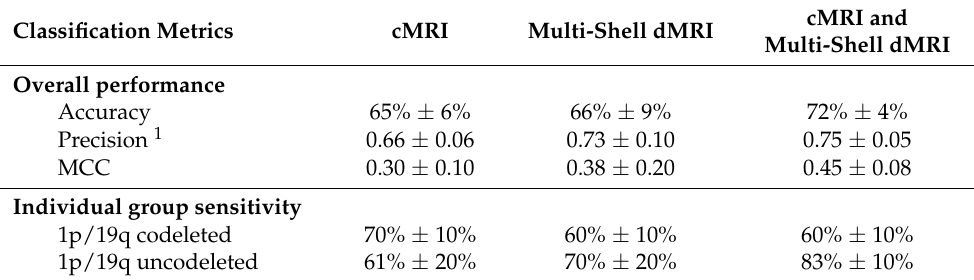
Table 4. 1p/19q status classification performance in LGGs (WHO